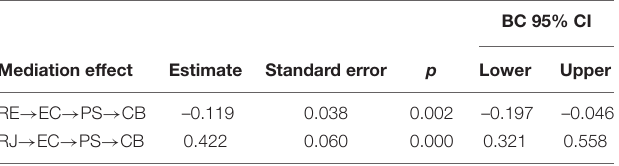
TABLE 6 | Bootstrapping results of serial mediation effects (Based on the most recent service recovery